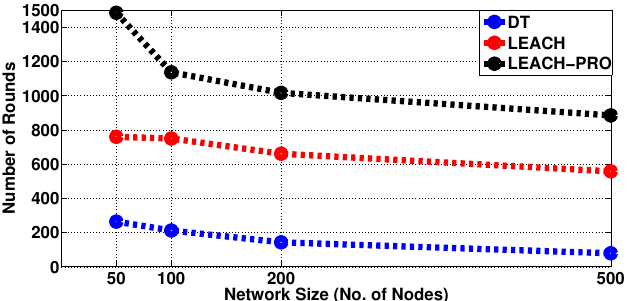
Figure 11. FND evolution under varying WSN